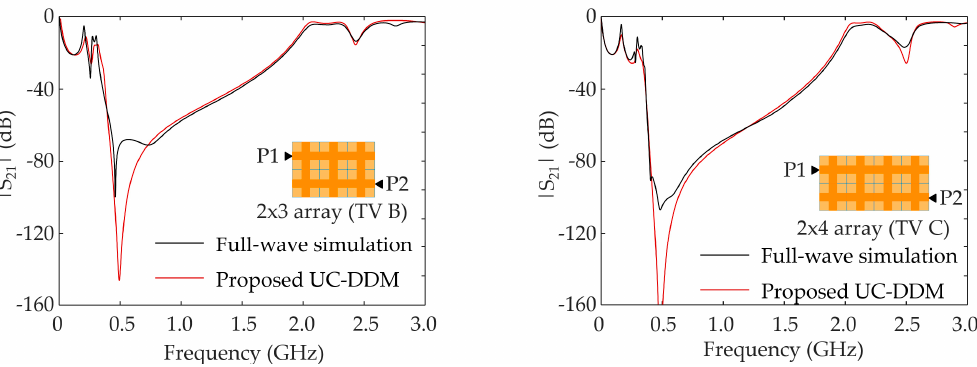
Figure 10. Comparison of PPN suppressions for 2 × 3 (test vehicle (TV) B) and 2 × 4 arrays (TV C).